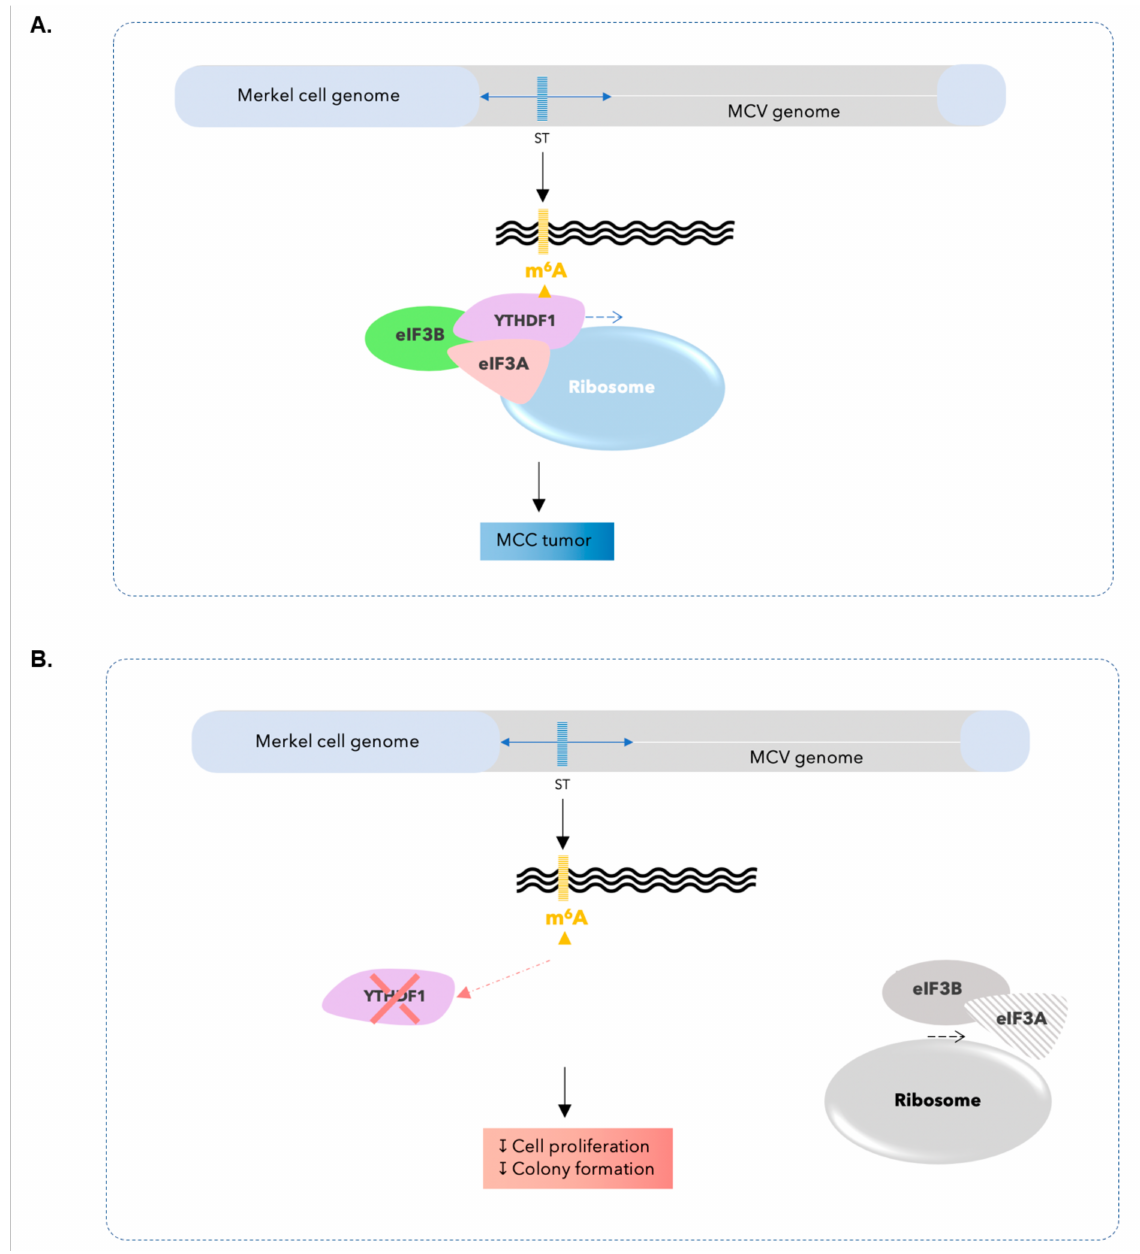
Figure 5. ( A ) A schematic figure demonstrating the identification of m 6 A modification in MCPyV transcriptome by YTHDF1 and further recruitment of eIF3A and 3B leading to the initiation of translation and MCC tumor. ( B ) YTHDF1 knockdown leads to lower eIF3A and 3B and lower levels of cell proliferation and